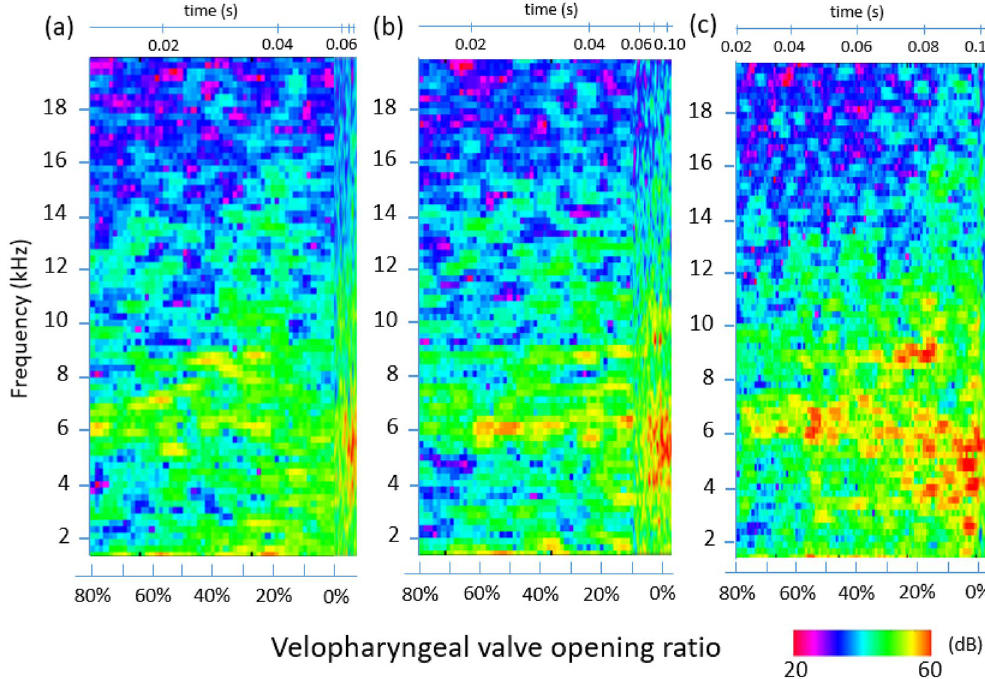
Figure 6. The far-field spectrogram with the closing speed of ( a ) 0.220 m/s (faster closing case), ( b ) 0.208 m/s (base simulation) and ( c ) 0.152 m/s (slower closing case) base on the velopharyngeal valve opening